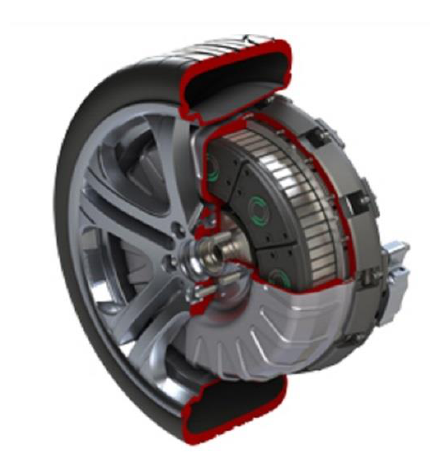
Fig. 3. Electric motor mounted in wheel hub made by Protean [9] Based on preliminary analyses, it has been established that a B class vehicle (d  1300 kg), equipped with two mc motors of this type should provide the required driving dynamics. For cars with a heavier weight, a solution with four drive motors should be used to obtain a suitably high driving